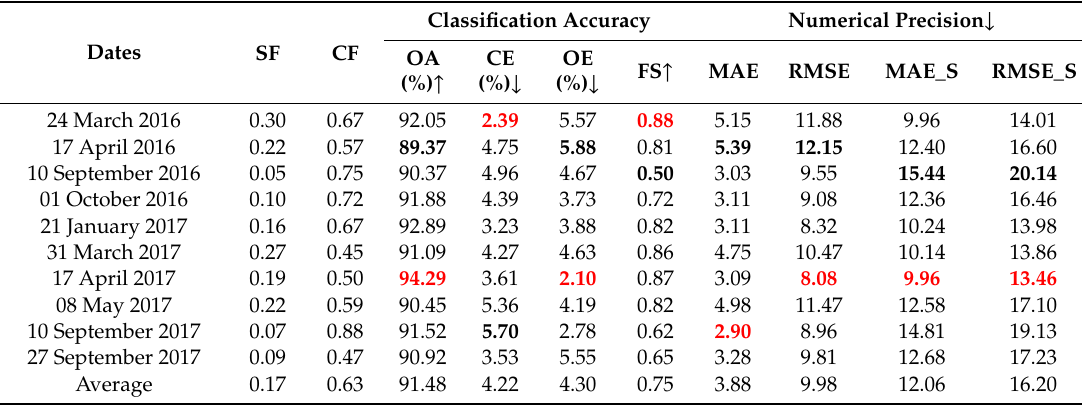
Figure 8. Details of A3 on 24 March 2016 (group (a)) and A4 on 10 September 2017 (group (b)). ( a1 , b1 ) “Ground truth”. ( a2 , b2 ) “Observed data”. ( a3 , b3 ) The cloud-removed results.